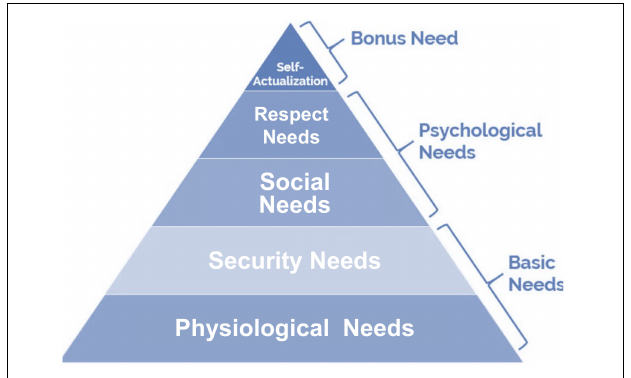
FIGURE 3 | Maslow’s Hierarchy of Needs